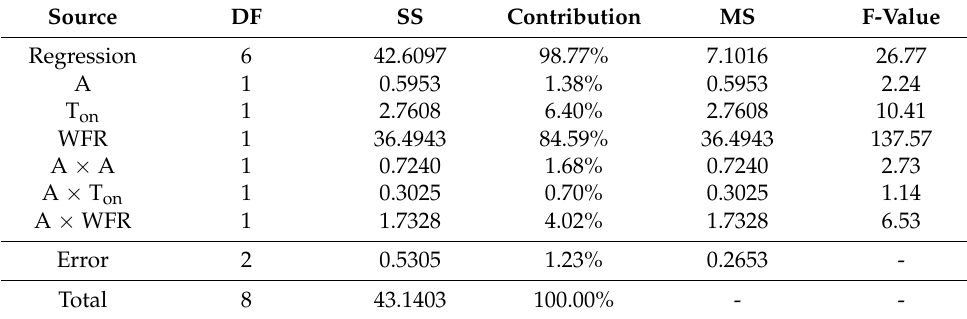
Table 8. Analysis of variance: surface roughness—Al6351–5% SiC–6% B 4 C.